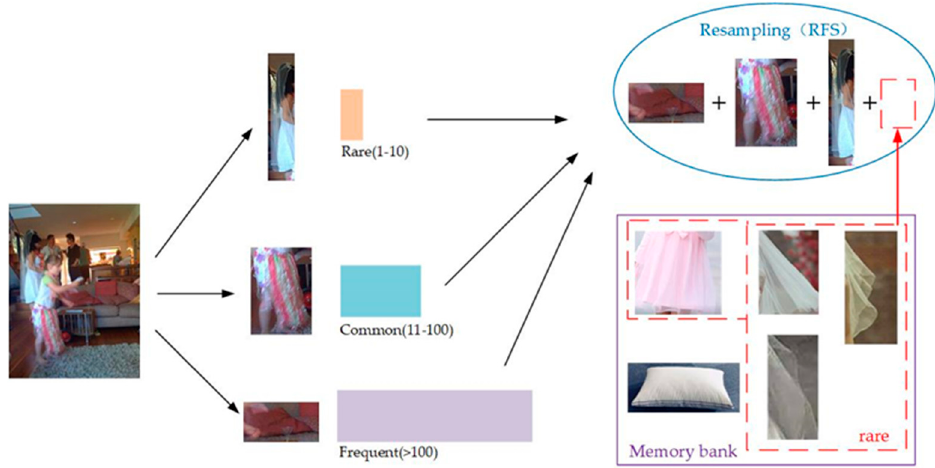
Figure 3. Specific resampling strategy in memory